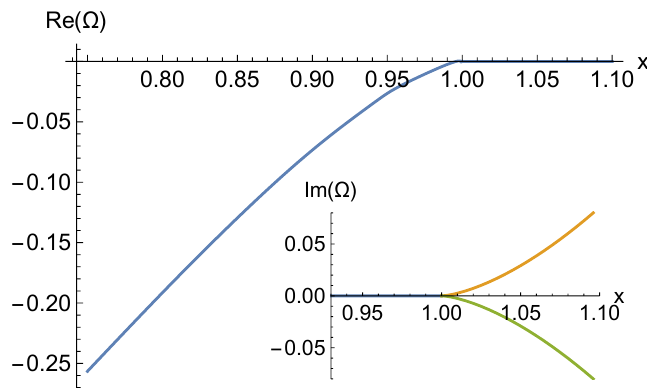
Figure 2: Free energy of the zero temperature solutions as a function of x . In the inset we plot the imaginary part, which is nonzero for x > 1. We have set M = 1. the horizon temperature.